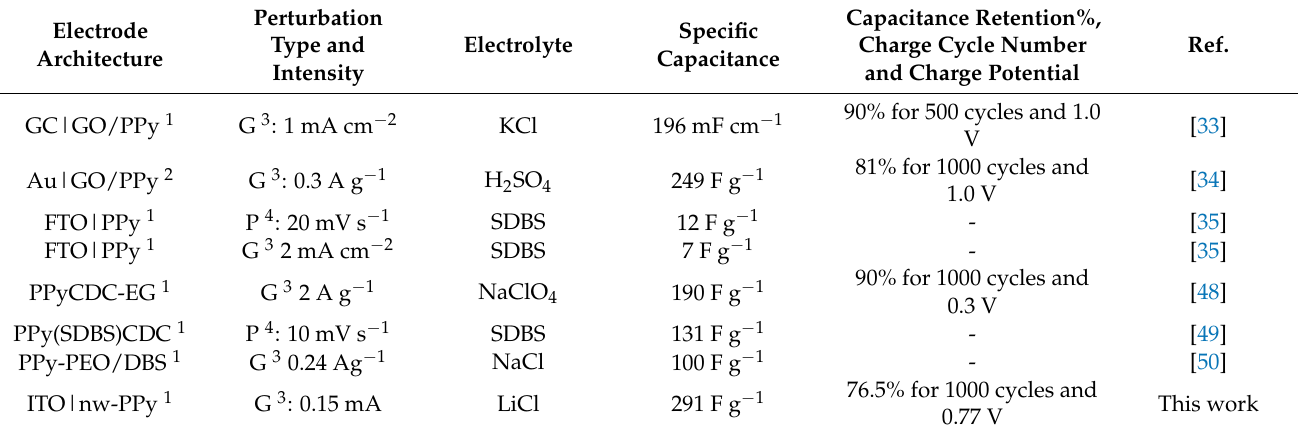
Table 3. Comparison of capacitive characteristics for other reports with similar materials.